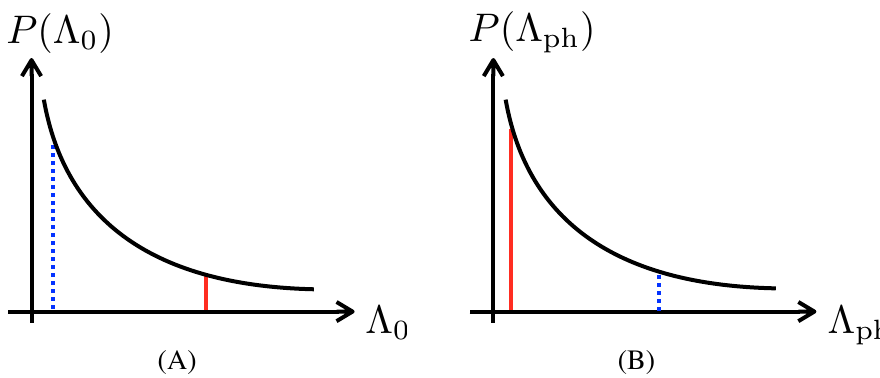
Figure 5 . The black curves in these schematic plots are the normalized probability distributions P ((cid:3)) for the tree-level (cid:3) 0 (A) and for the physical (cid:3) ph (B). Both P ((cid:3)) diverge logarithmically at (cid:3) = 0. The red solid lines represent (cid:3) 0 and (cid:3) ph calculated with (cid:13)ux values ( a 1 ; b 1 ) while the blue dotted lines represent (cid:3) 0 ( a 0 ; b 0 ) and (cid:3) ph ( a 0 ; b 0 ). Here, the small values (cid:3) 0 ( a 0 ; b 0 ) and (cid:3) ph ( a 1 ; b 1 ) are statistically